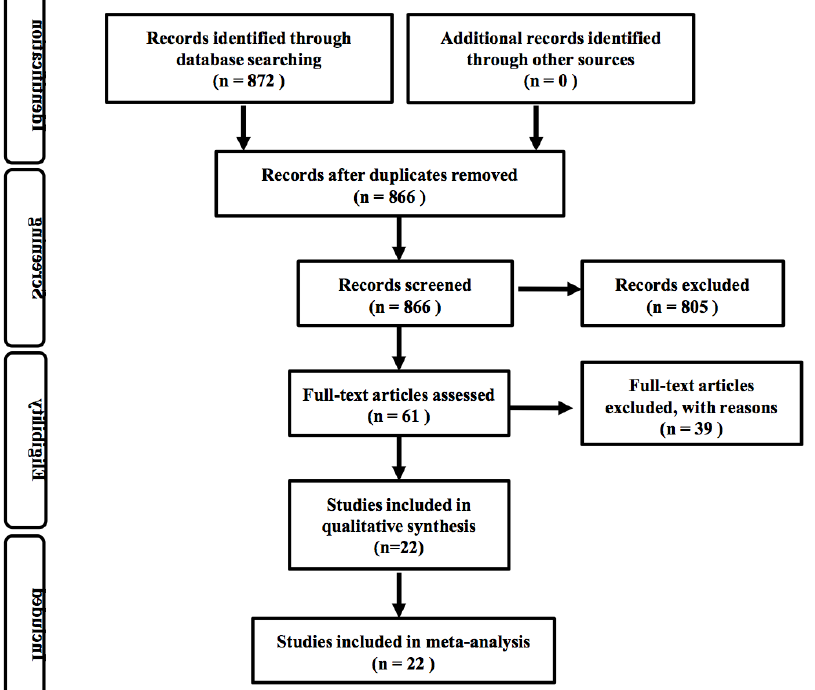
Figure 1: The publication searching flow